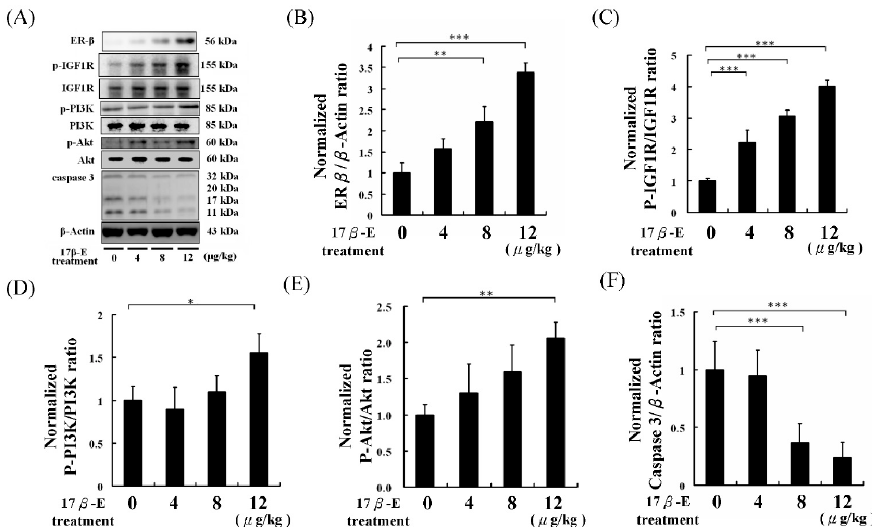
Figure 3. The cardiac survival and apoptosis biomarker analysis of 60 days of different doses of 17 β -estradiol treatments (0, 4, 8, 12 µ g/kg/day) for high-fat diet-fed male C57B mice ( n = 6 in each group). ( A ) The hearts protein samples Western blotting analysis results of ER β , p-IGF1R, IGF1R, p-PI3K, PI3K, p-Akt, Akt, caspase 3, and β -actin. ( B ) The normalized protein expression of ER β / β -actin. ( C ) The normalized protein expression of p-IGF1R/ β -actin. ( D ) The normalized protein expression of p-PI3K/ β -actin. ( E ) The normalized protein expression of p-Akt/ β -actin. ( F ) The normalized protein expression of caspase 3/ β -actin. (* = p < 0.05, ** = p < 0.01, *** = p < 0.001 compared with indicated group.)